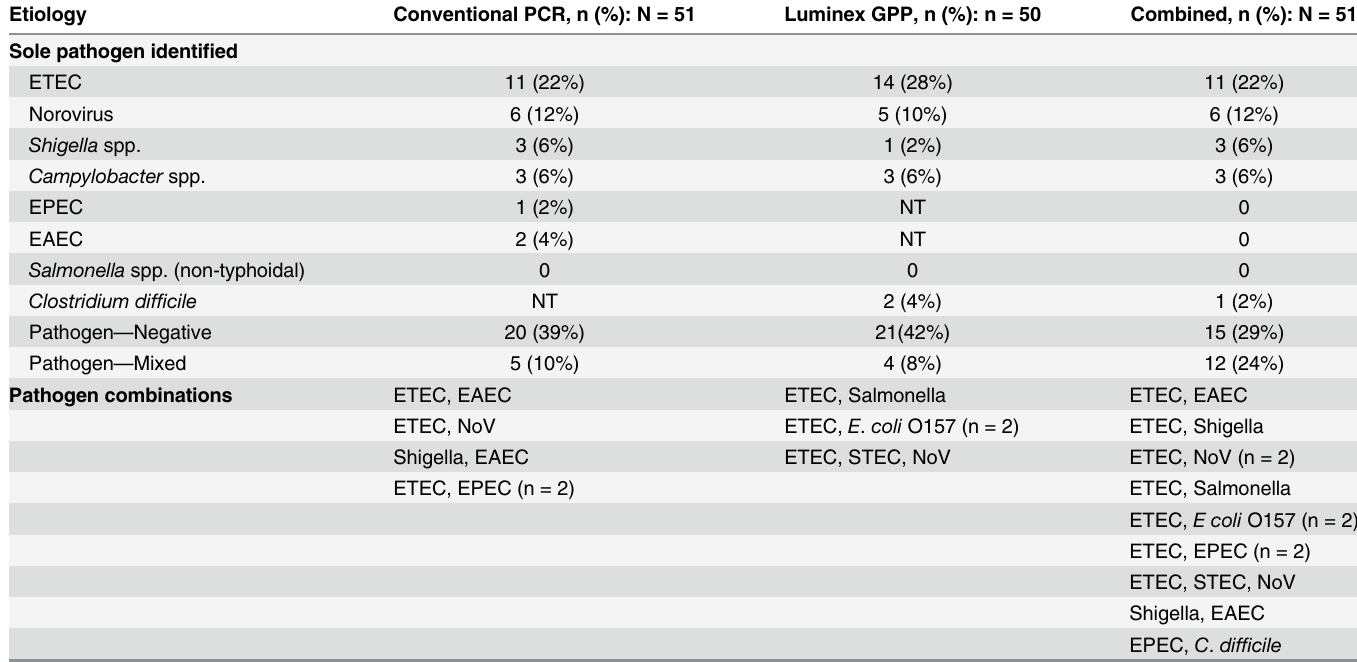
Table 4. Pathogen Etiology Identified By Two Culture-Independent